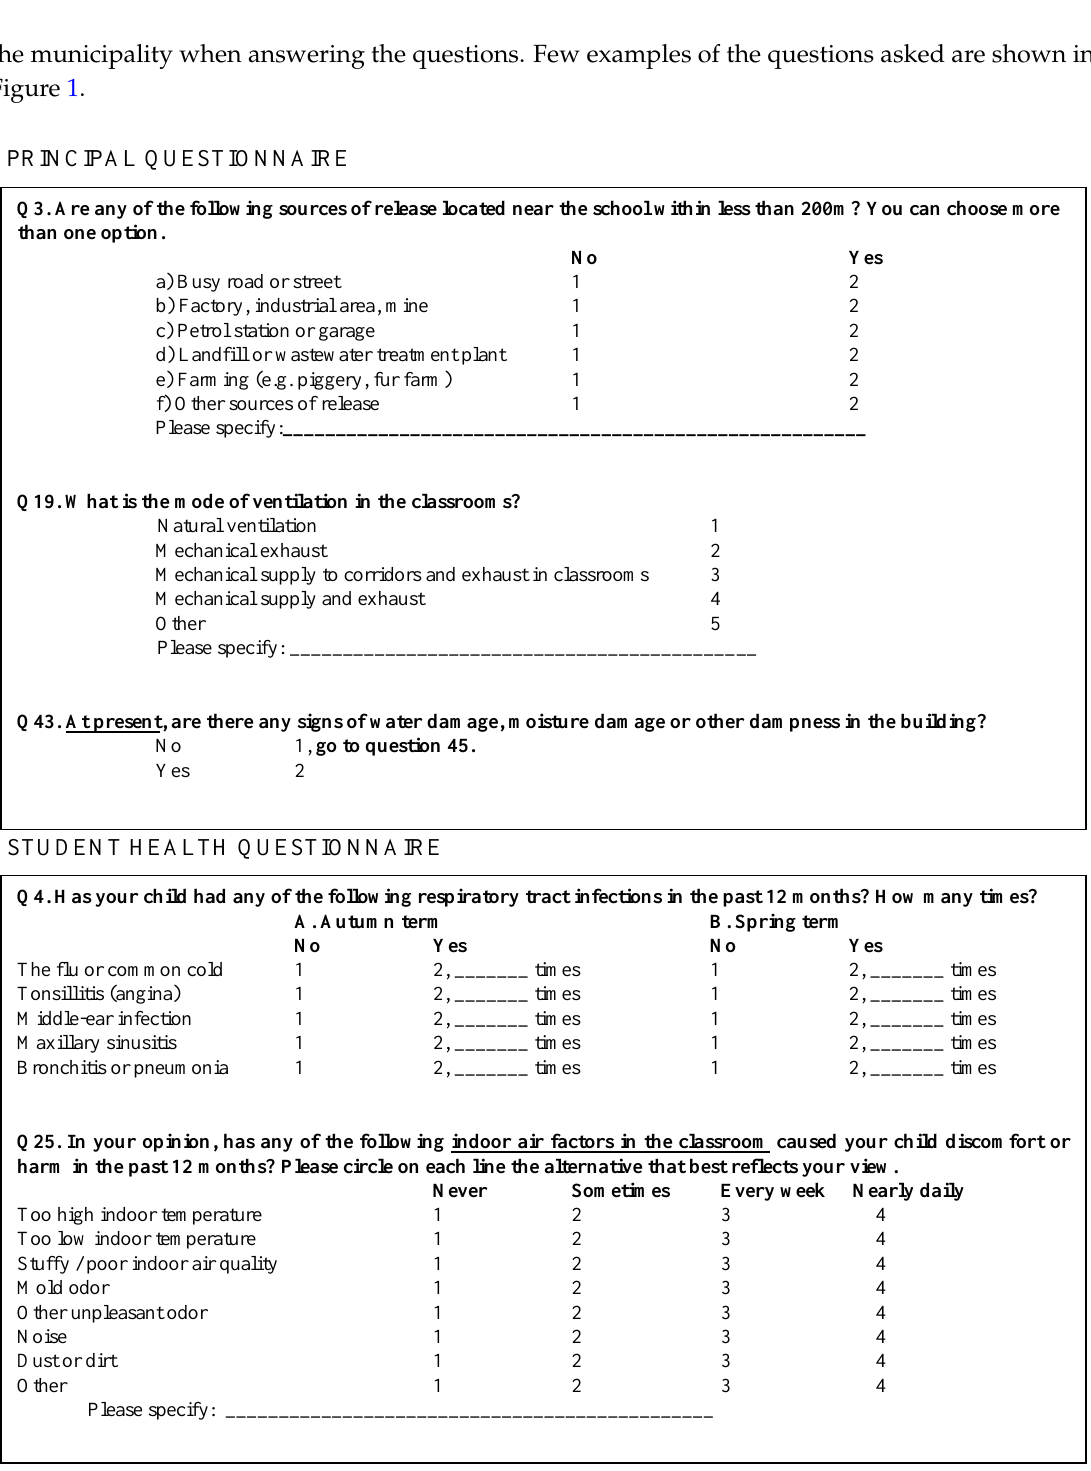
Figure 1. Example of questions from the principal and student health questionnaires.